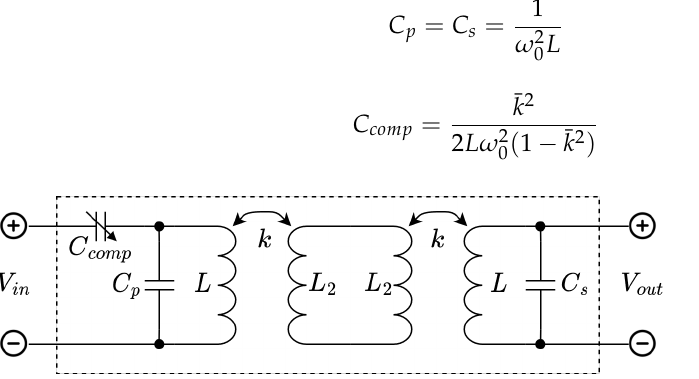
Figure 5. Proposed three capacitor compensation